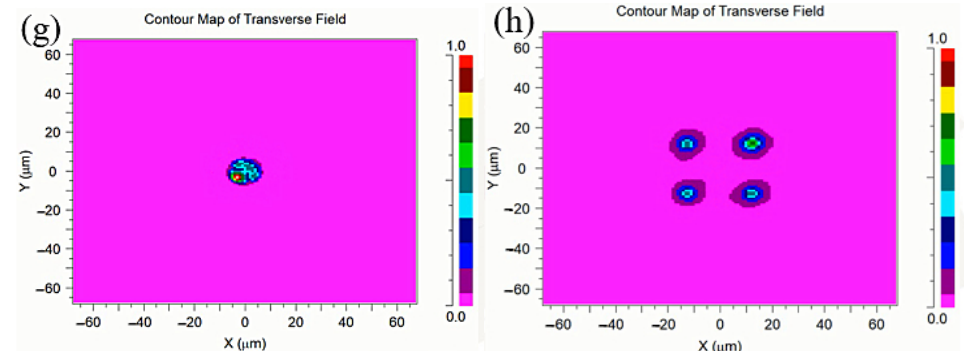
Figure 2. ( a ) The cross section of the FCF; ( b ) The input excitation was defined as the input in the upper right corner; ( c – g ) The normalized electrical field intensity profiles of supermodes in TFCF when the FCF diameter gradually decreased; ( h ) The normalized electrical field intensity profiles when the input light passed through one conical region of the TFCF to the other side.